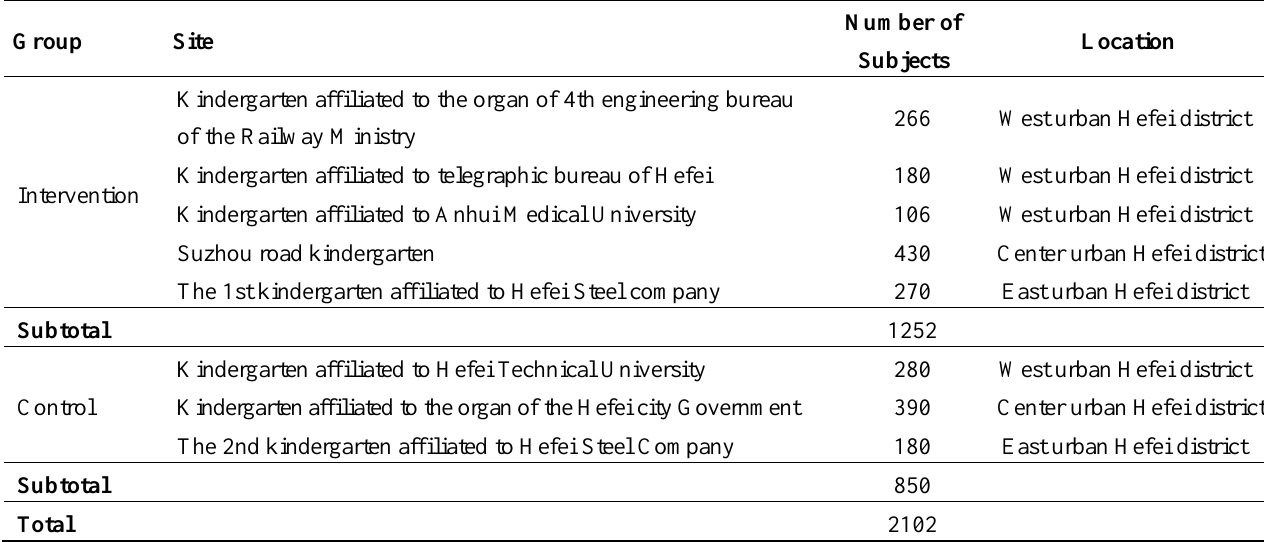
Table 1. Components in intervention and control